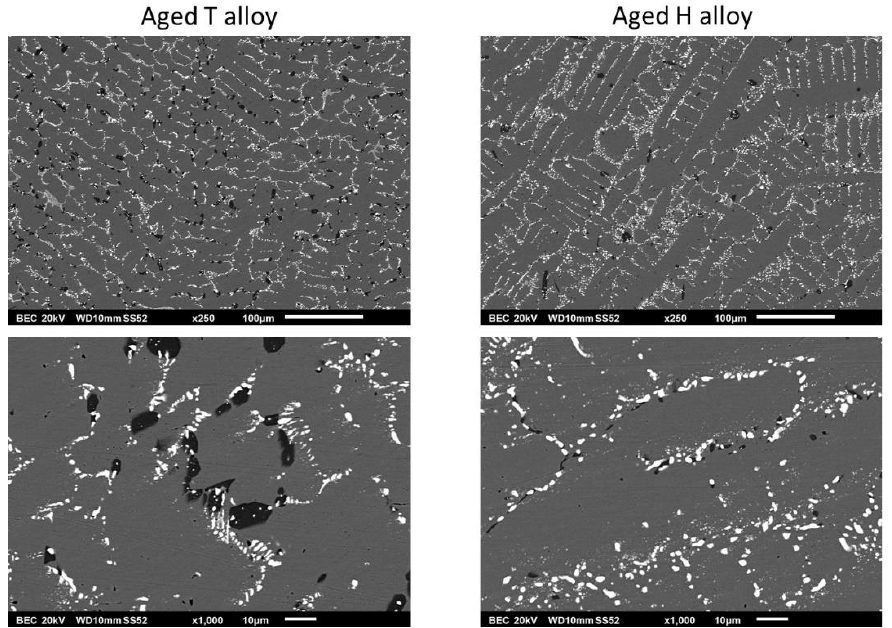
Figure 14. Microstructures in the bulk after exposure at 1250 °C for 50 h ( left : T alloy, right : H alloy, top : general view, bottom : detailed view). Table 6. Chemical composition of the matrixes of the two alloys after exposure at 1250 °C for 50 h.